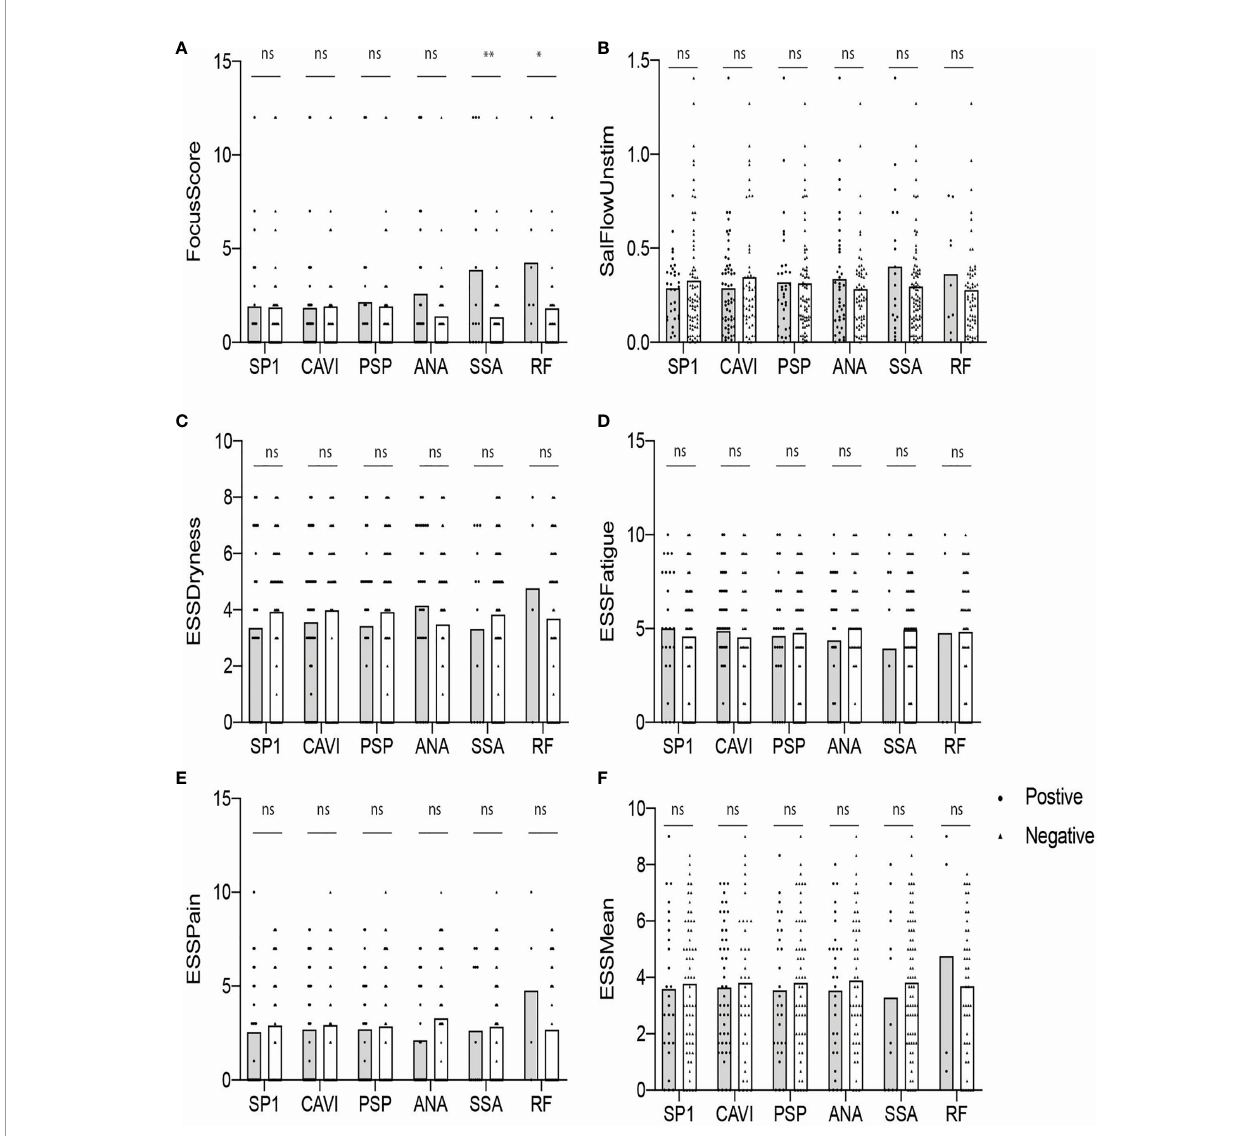
FIGURE 3 | Autoantibody-positive and -negative groups plotted for objective and subjective parameters (A – F) . The statistical signi fi cance is displayed above the bracket of each bar. The brackets were not depicted and p-values were not calculated when the sample number was below 3 in either group. Each dot depicts actual value of the parameter for each subject. Gray bar, autoantibody positive group; white bar, autoantibody negative group; ns, not signi fi cant; *p ≤ 0.05; **p ≤